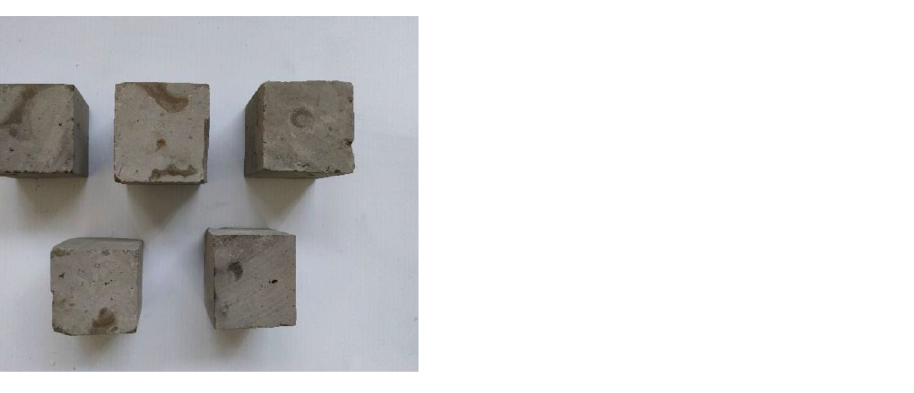
Figure 18. Evidence of sample